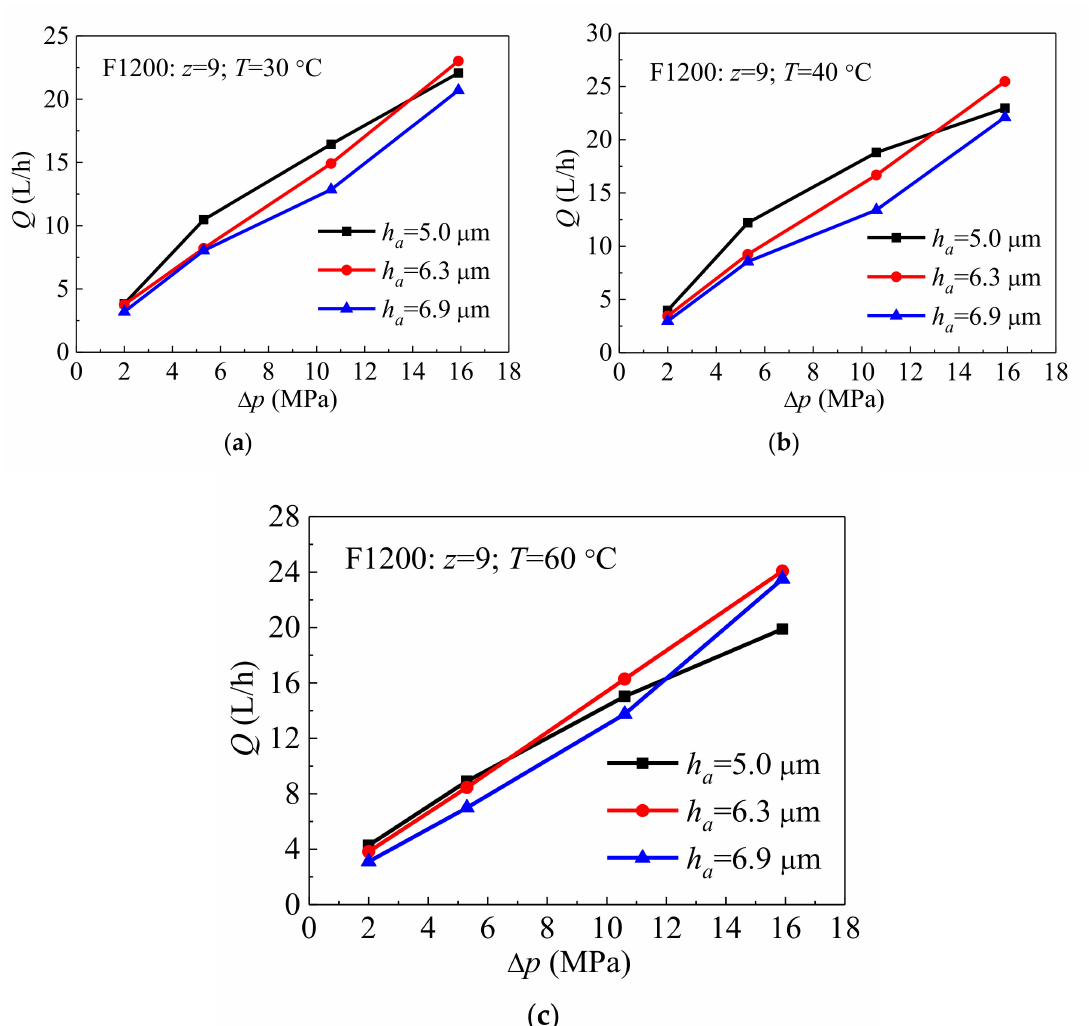
Figure 9. The comparison of the leakage rate at di ff erent waviness amplitude, including ( a ) T = 30 ◦ C, ( b ) T = 40 ◦ C, ( c ) T = 60 ◦